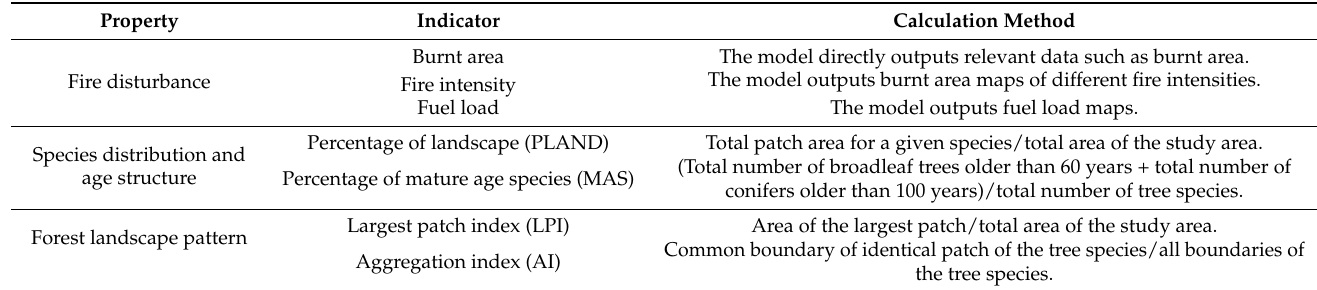
Table 5. Evaluation indicators used in this